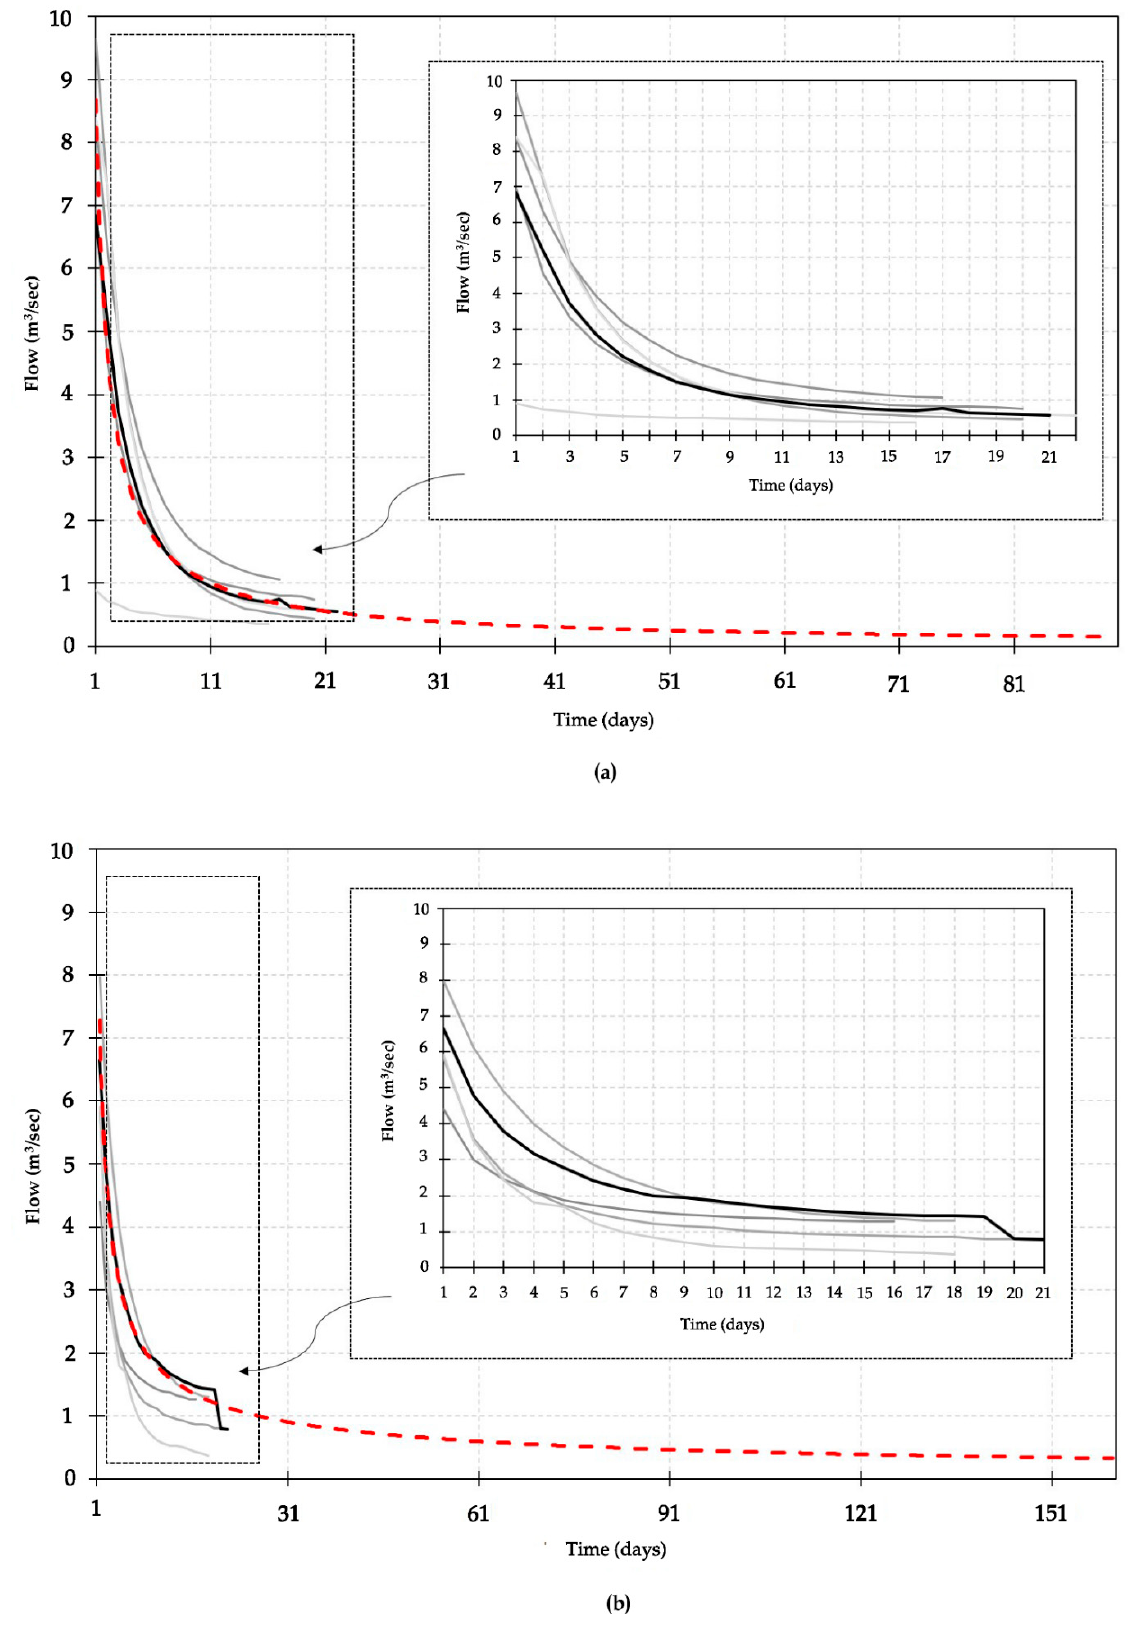
Figure 11. Results of calculating the available number of water intake days curve equation during ( a ) spring and ( b ) sum- mer.